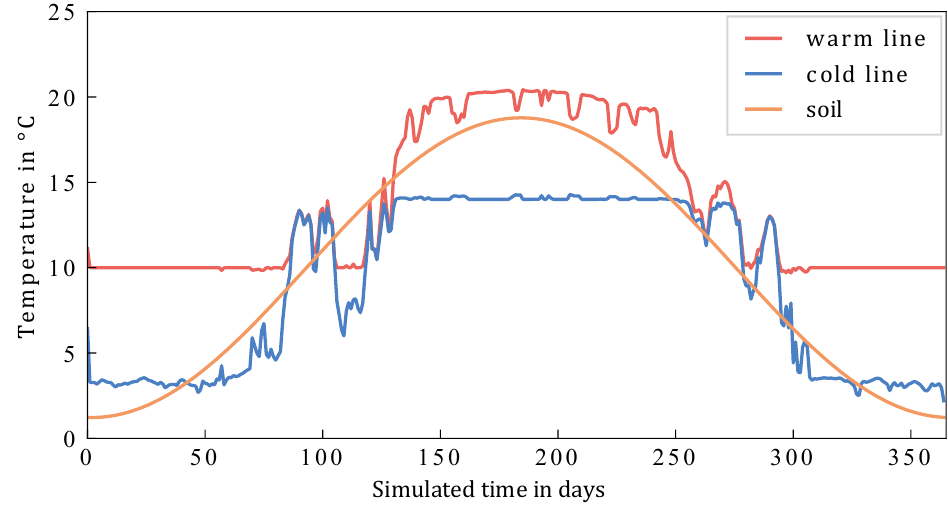
Figure 17. Temperatures of warm and cold line at supply (S1) and soil